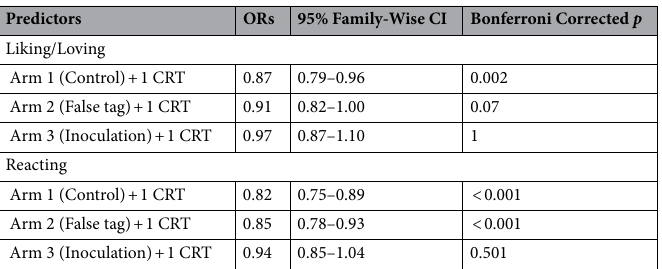
Table 4. The estimated effects of a one-point increase on the CRT, per arm and per